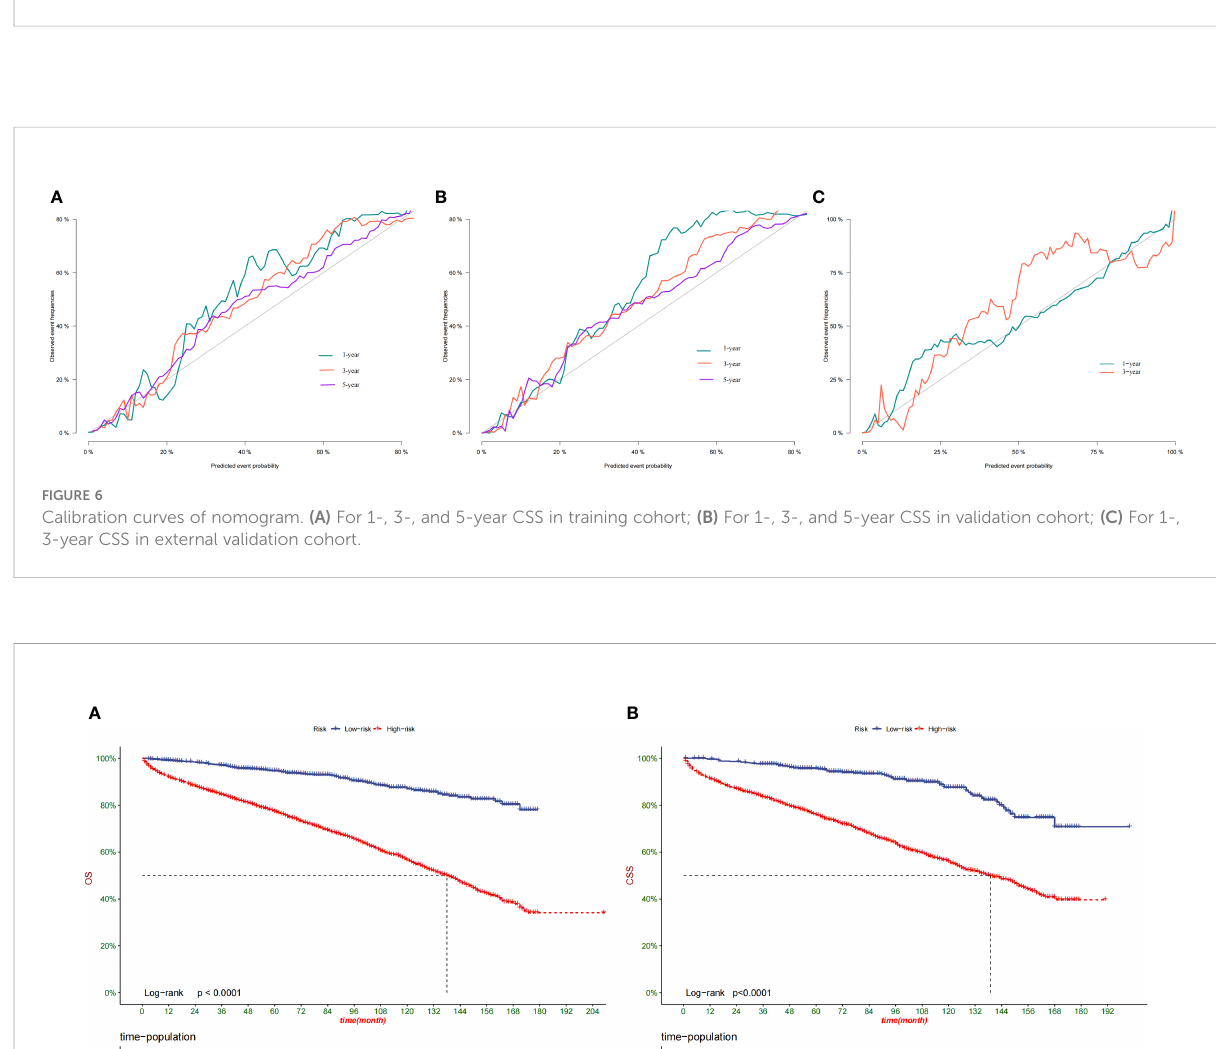
FIGURE 5 Decision curves of the nomogram predicting OS in training cohort (A) , validation cohort (B) and external validation cohort (C) . The y-axis represents the net bene fi t, and the x-axis represents the threshold probability. When the threshold probability is between 20% and 60%, the net bene fi t of the model exceeds all deaths or no deaths.